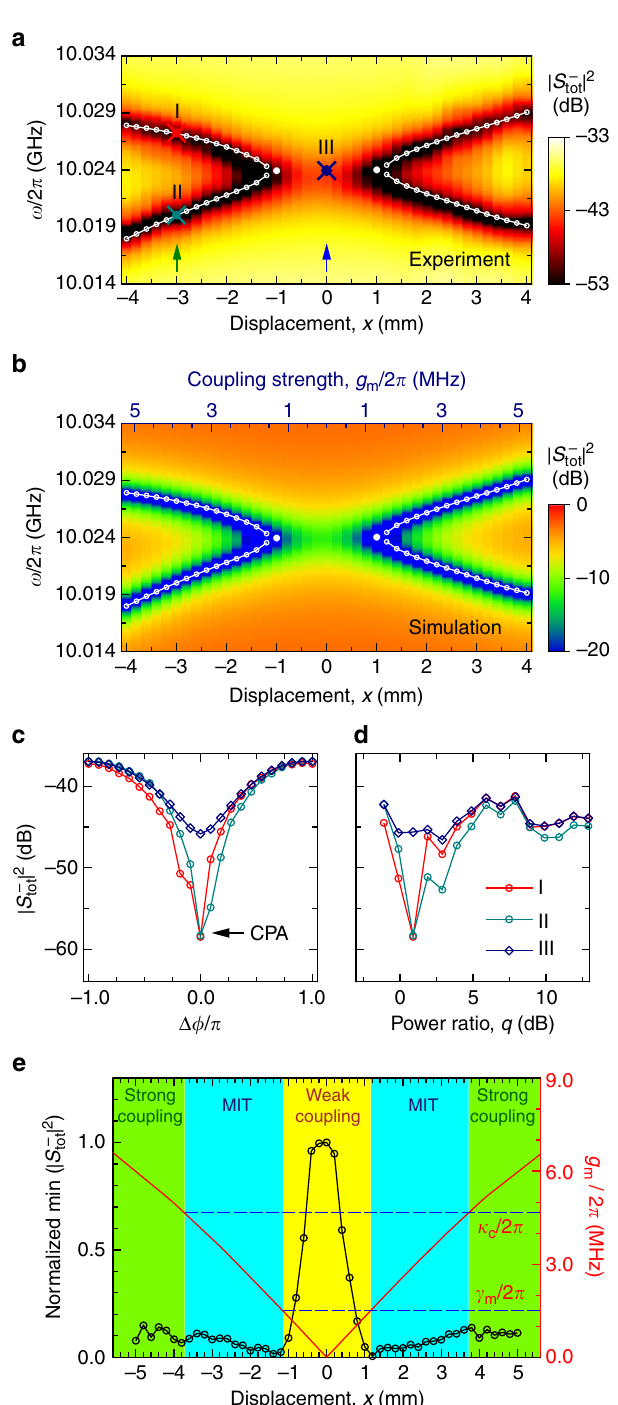
Fig. 3 Observation of the exceptional point in cavity magnon – polaritons. a Measured total output spectrum vs. the displacement of the YIG sphere in the cavity. b Calculated total output spectrum corresponding to the measured results in a . Corresponding coupling strength is indicated according to the relation g m /2 π = 1.3 x j j . In a , b , the open-circle curves are the eigenfrequencies calculated using Eq. (3). c Dependance of the total output spectrum on Δ ϕ . d Dependance of the total output spectrum on the power ratio. For the three curves (I, II, and III) in c , d , the corresponding locations in a are marked with crosses (red, green, and navy). e Phase transition between the magnetically induced transparency (MIT) regime and the weak-coupling regime. The black open-circle curve corresponds to the minima of the total output transmission vs. the displacement of the YIG sphere, where each value in the MIT and strong-coupling regions is the average value of the two minima of the two CPA branches at a given